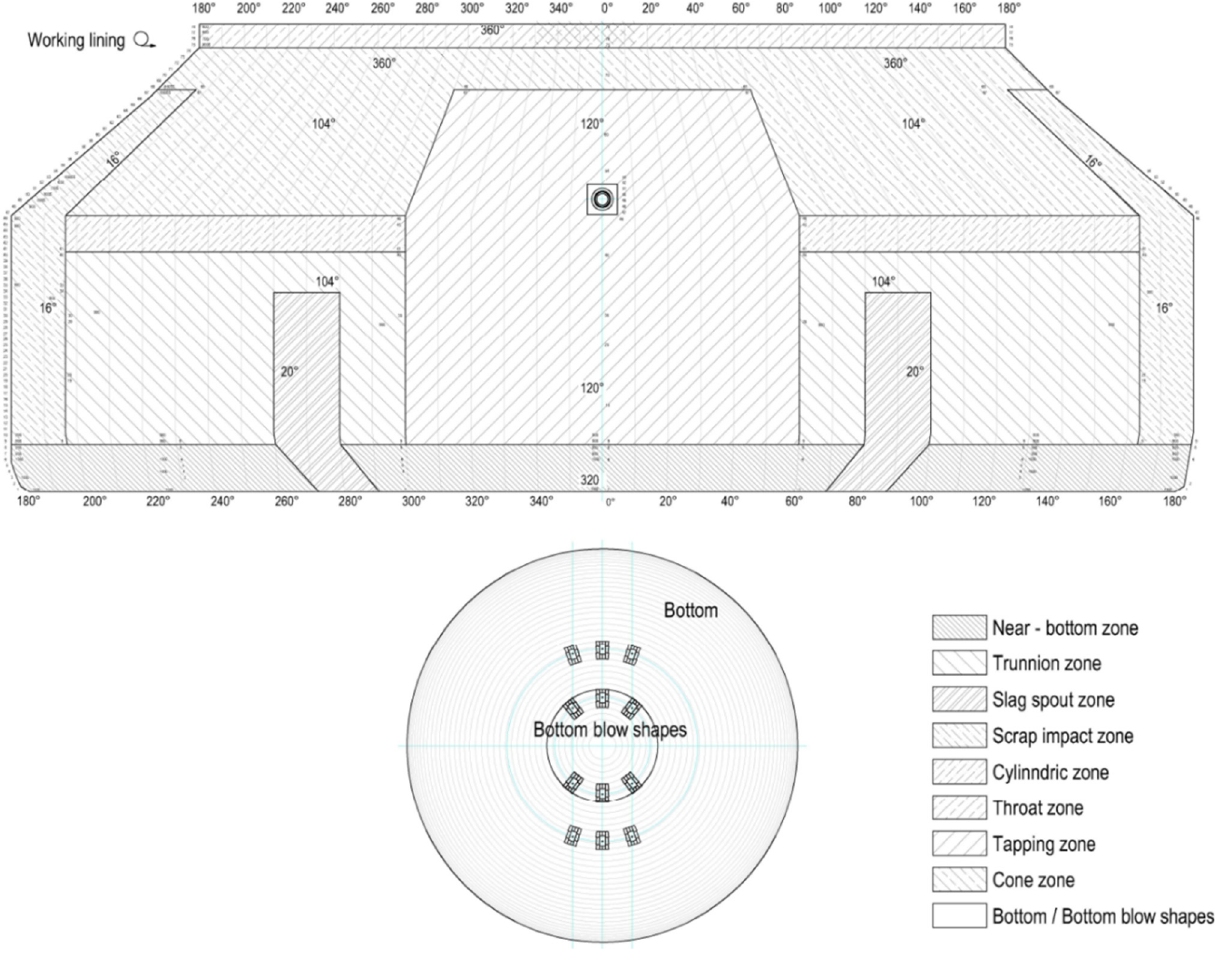
Figure 1. Zone scheme of the working lining with refractory materials.